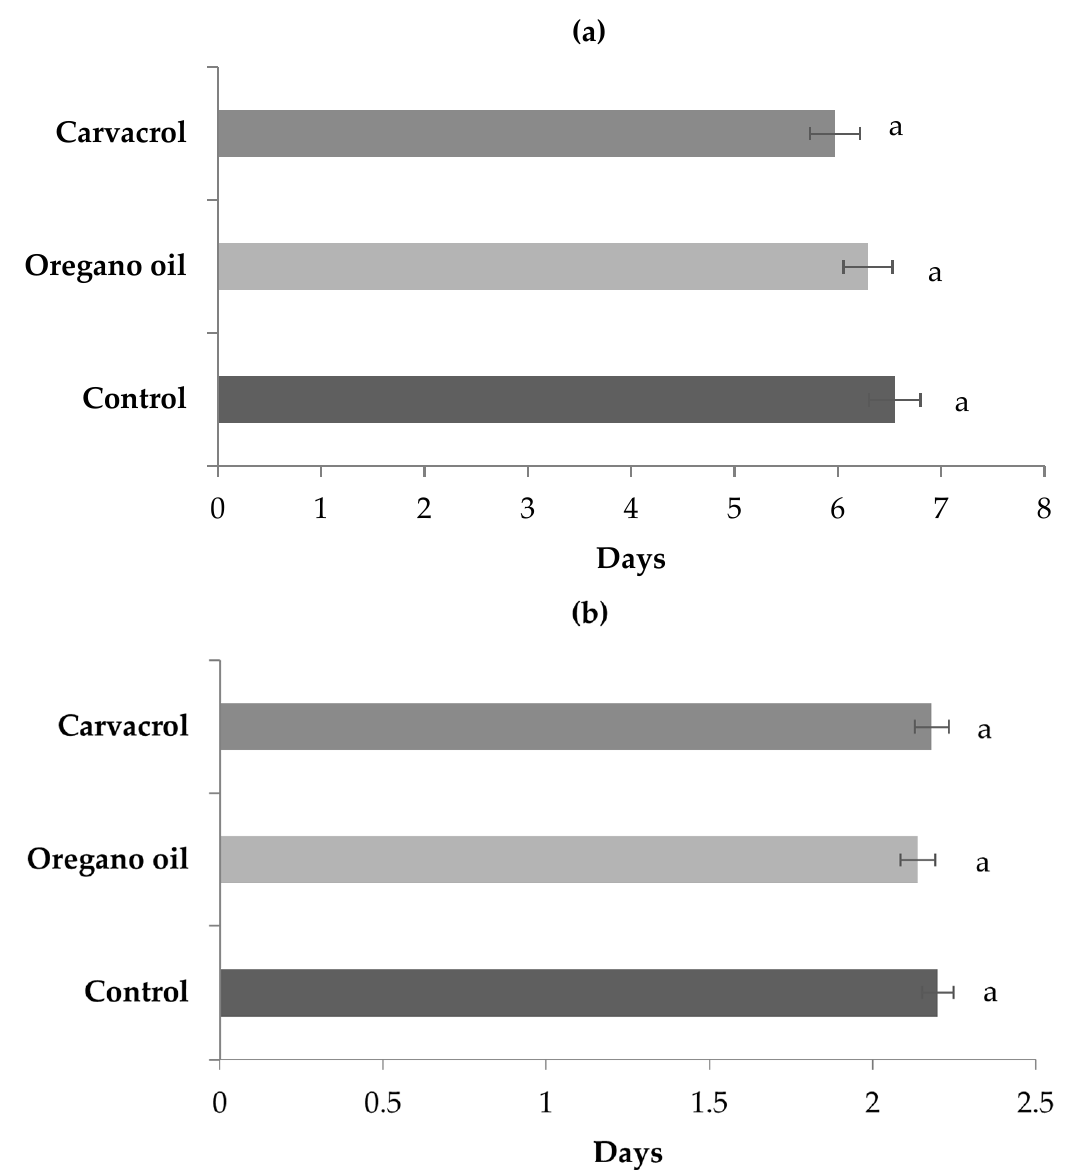
surviving pupae until adulthood ( p = 0.717), when compared to the untreated control.